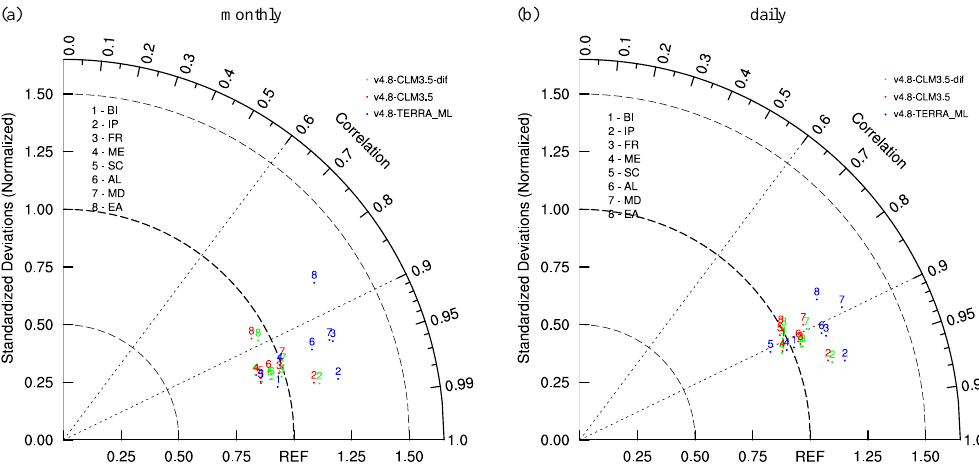
Fig. 9. Taylor diagram for 2-meter temperature displaying the correlation and ratio of variance (normalized standard deviation) in reference to E-OBS. The statistics are shown for different regions and are based on a) monthly and b) daily means for the summer period (JJA).